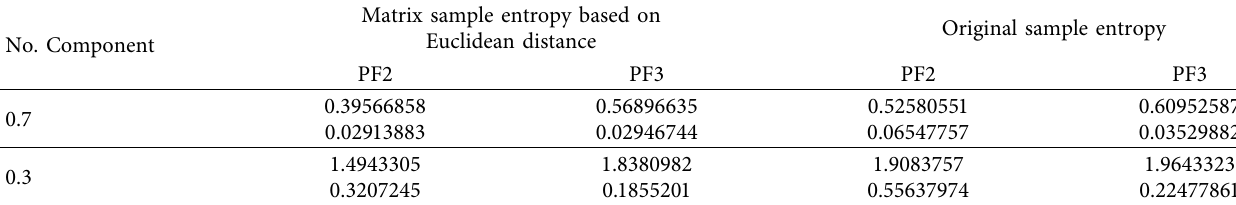
Table 3: Two entropies of compound fault